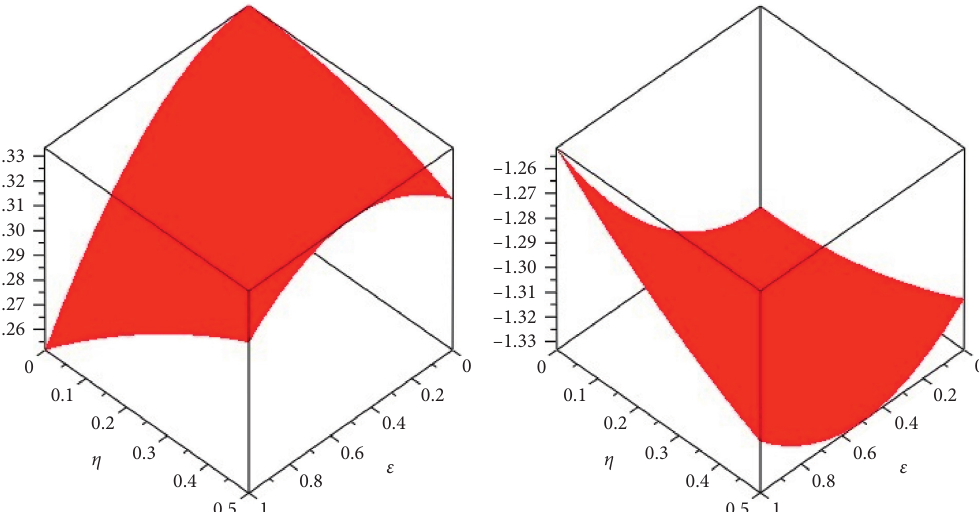
Figure 1: Upper and lower fuzzy figure of analytical solution of example 1.